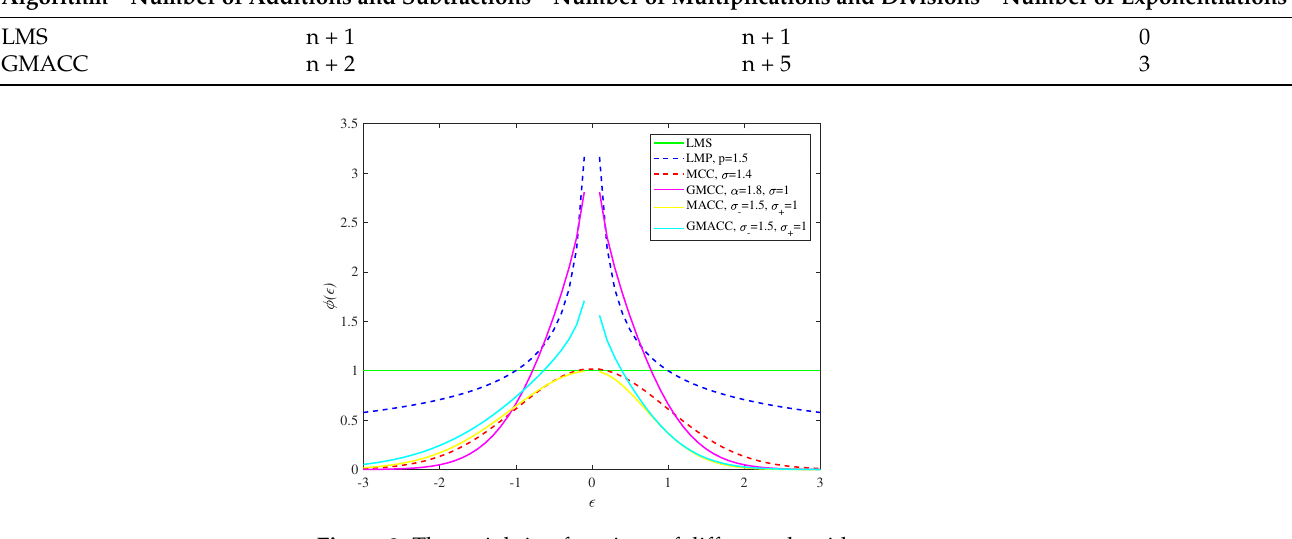
Figure 2. The weighting functions of different